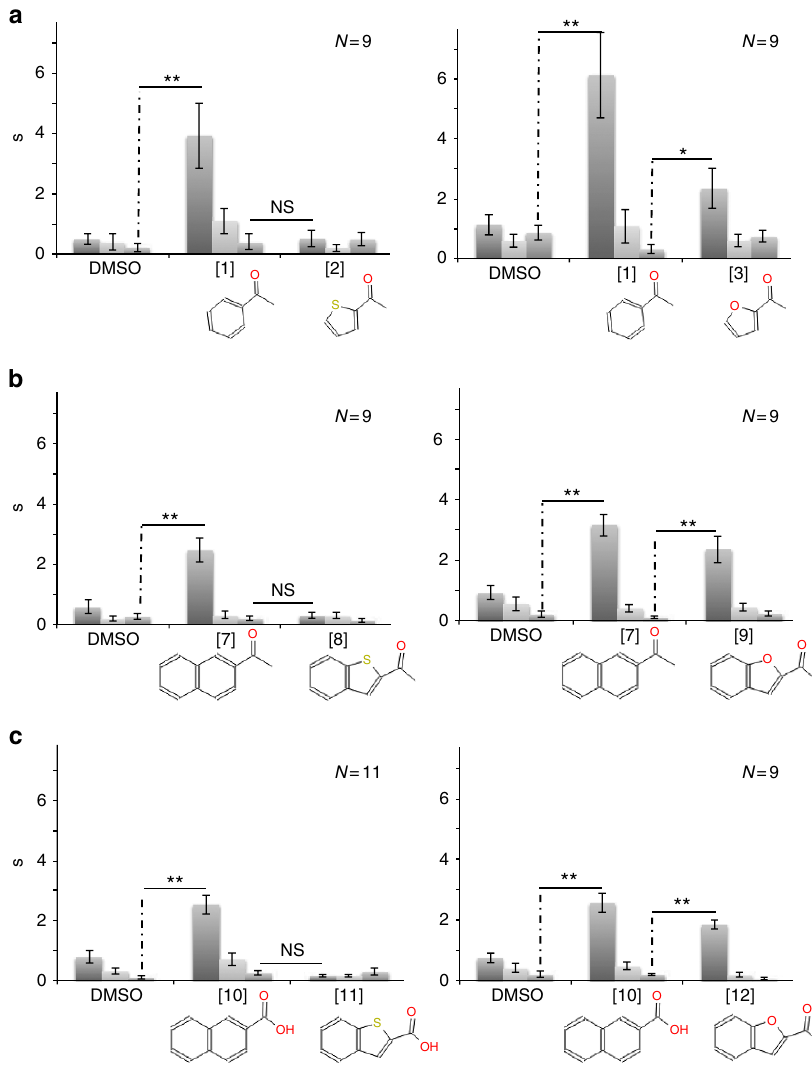
Figure 4 | Habituation–dishabituation olfactory test. The average olfactory investigation time (s) by mice during repetitive 2min exposures to odorant pairs or DMSO (solvent). ( a ) Mice that habituated to [1] remained habituated to [2] but dishabituated to [3]. ( b ) Mice that habituated to [7] remained habituated to [8] but dishabituated to [9]. ( c ) Mice that habituated to [10] remained habituated to [11] but dishabituated to [12]. In all cases, the analogue with the low TPSA thiophene ring was not discriminated from the lead, low TPSA benzene-ringed version, but the analogue with the higher TPSA furan ring was. Behaviour tests were analysed using ANOVA test followed by a post hoc paired t -test (* P o 0.05, ** P o 0.005 paired post hoc t -test). NS, not significant, * P -value o 0.05, ** P -value o 0.005 paired t -test. Error bars: s.e.m. N , number of